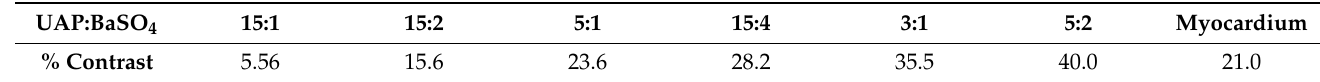
Figure 4. X-ray imaging of Layfomm-40 cylinders coated with UAP mixed with increasing amounts of BaSO 4 . ( A ) mass ratio15:1 UAP:BaSO 4, ( B ) 15:2, ( C ) 5:1, ( D ) 15:2, ( E ) 3:1, ( F ) 5:2, and ( G ) clinical image showing the left heart border (red oval). Table 2. The maximum percentage image contrast for BaSO 4 –UAP coated Layfomm-40 cylinders at different UAP:BaSO 4 mass ratios compared to myocardial contrast achieved in clinical images.